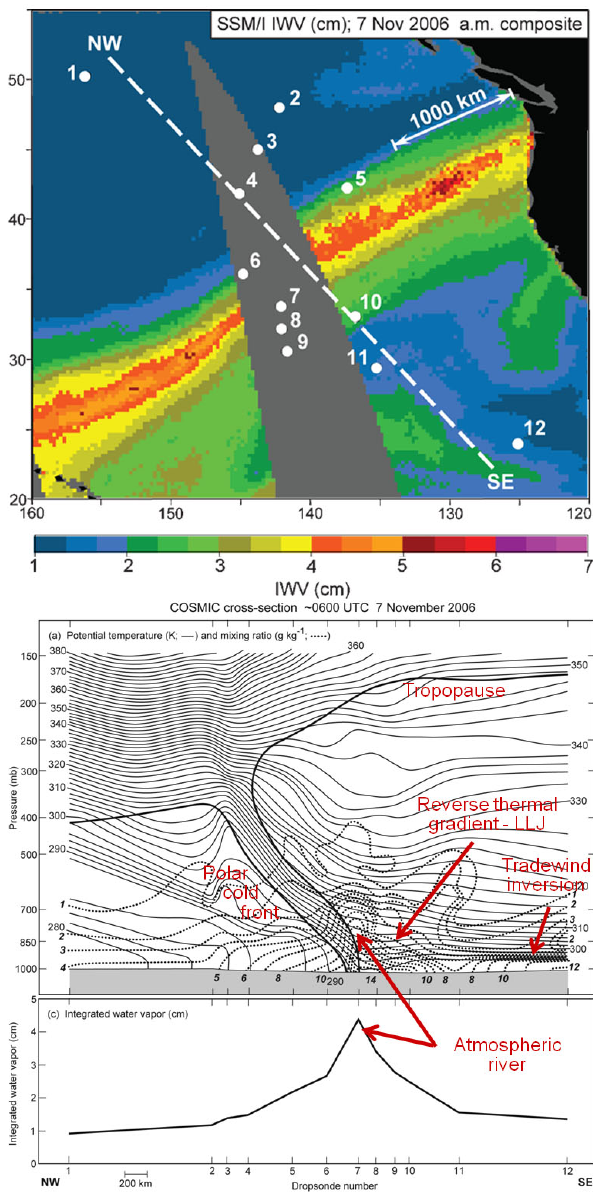
Fig. 19. Cross section of potential temperature (K) and mixing ratio (gkg − 1 ) perpendicular to a front and associated atmospheric river, 7 November 2006, based on COSMIC observations only (Neiman et al., 2008).